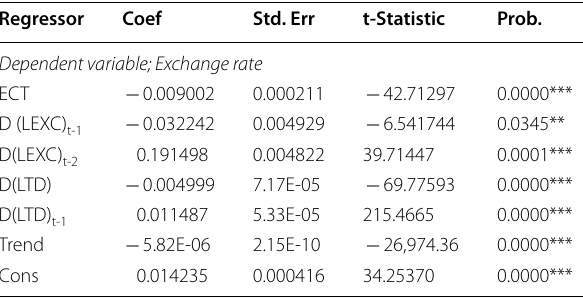
** , ***Represents 5% and 1% level of significances, respectively